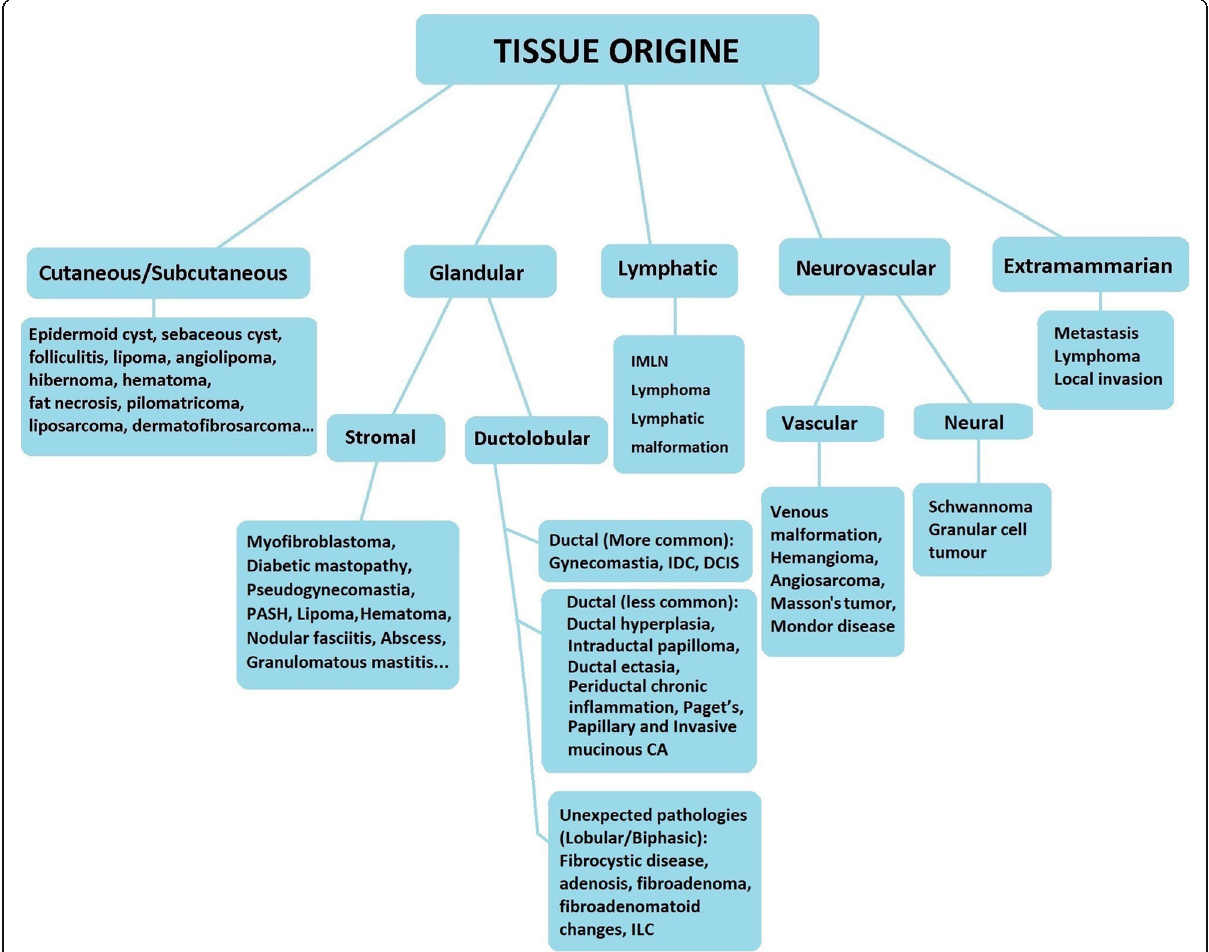
Fig. 6 Classification based on “ Tissue origin